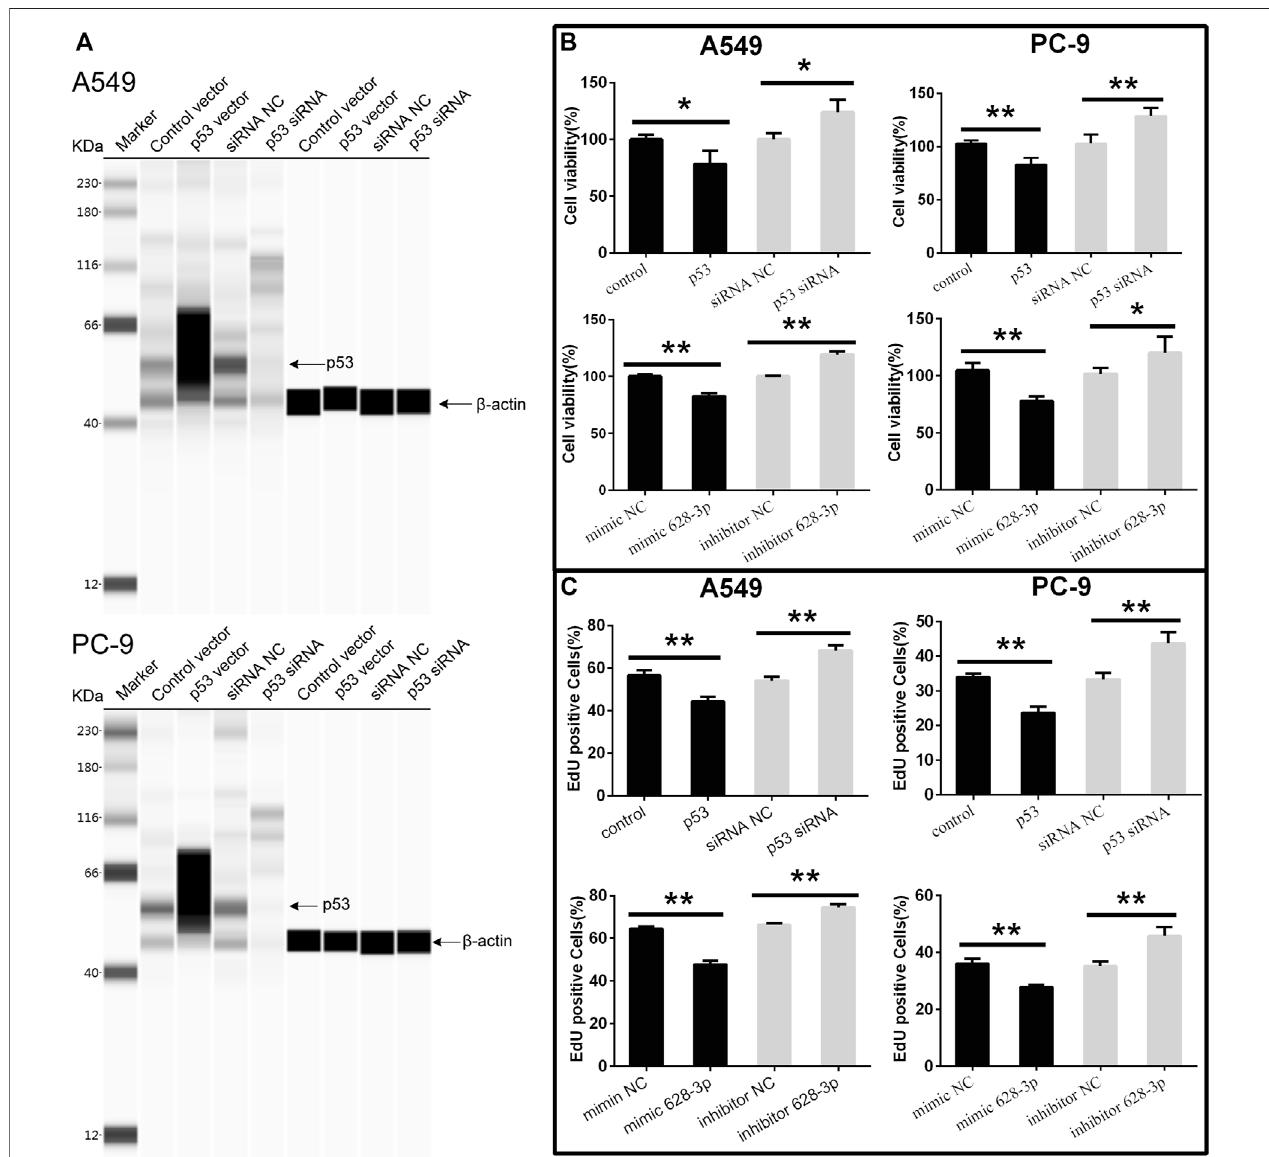
FIGURE 4 | Cell viability of A549 and PC-9 cells. p53-overexpression plasmid (p53) or its control vector, p53 speci fi c siRNA or siRNA NC, mimic 628-3p, inhibitor 628-3p,ortheircorrespondingnegativecontrolwastransfectedintoA549orPC-9cellsbyLipofectamine3000asindicated.Then (A) totalproteinswereextracted,and p53 protein levels were determined on a Simple Wes System; (B) CCK-8 assay and (C) EdU assay were performed after 24 h of transfection. All measurements were carried out in triplicates, and data are given as mean ± SD ( n (cid:2) 3). * p < 0.05, ** p < 0.01.